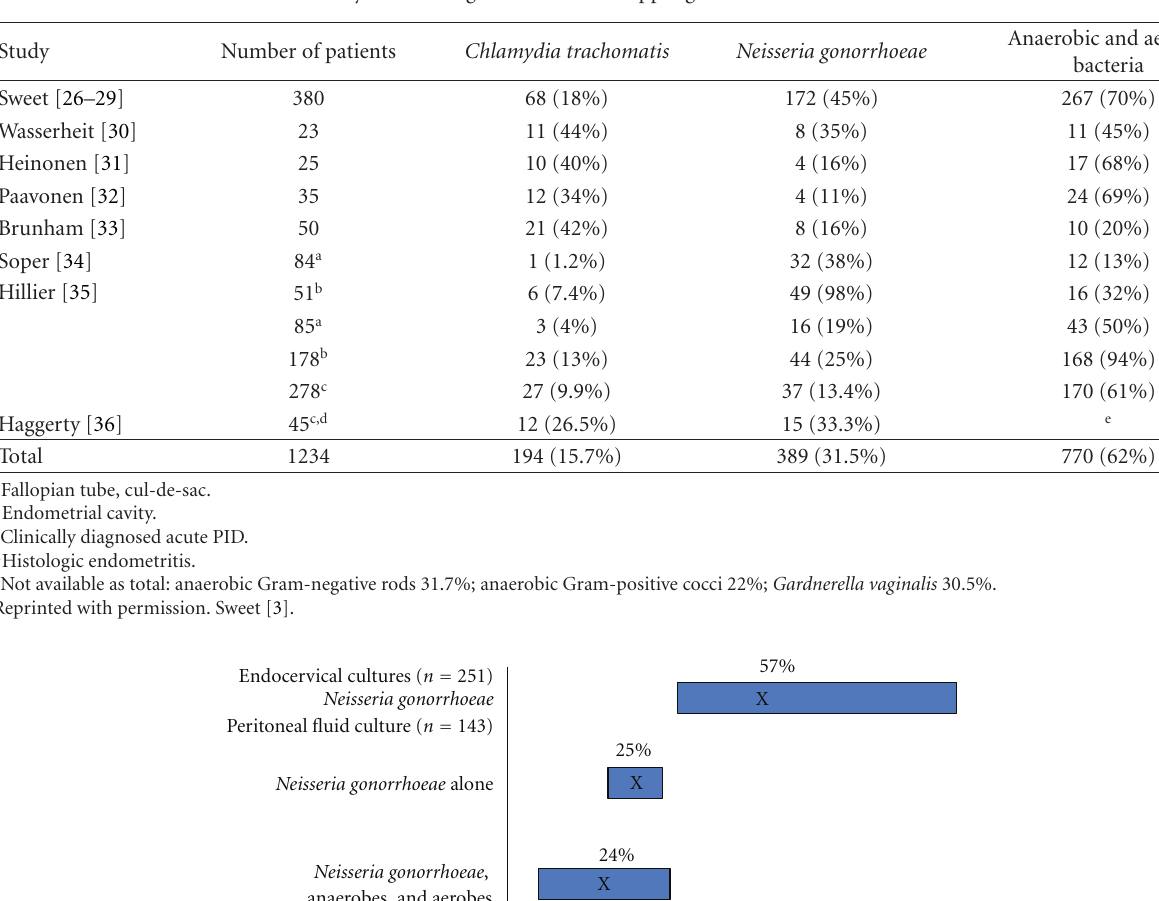
Table 1: Recovery of microorganisms from the upper genital tract of women with acute PID.